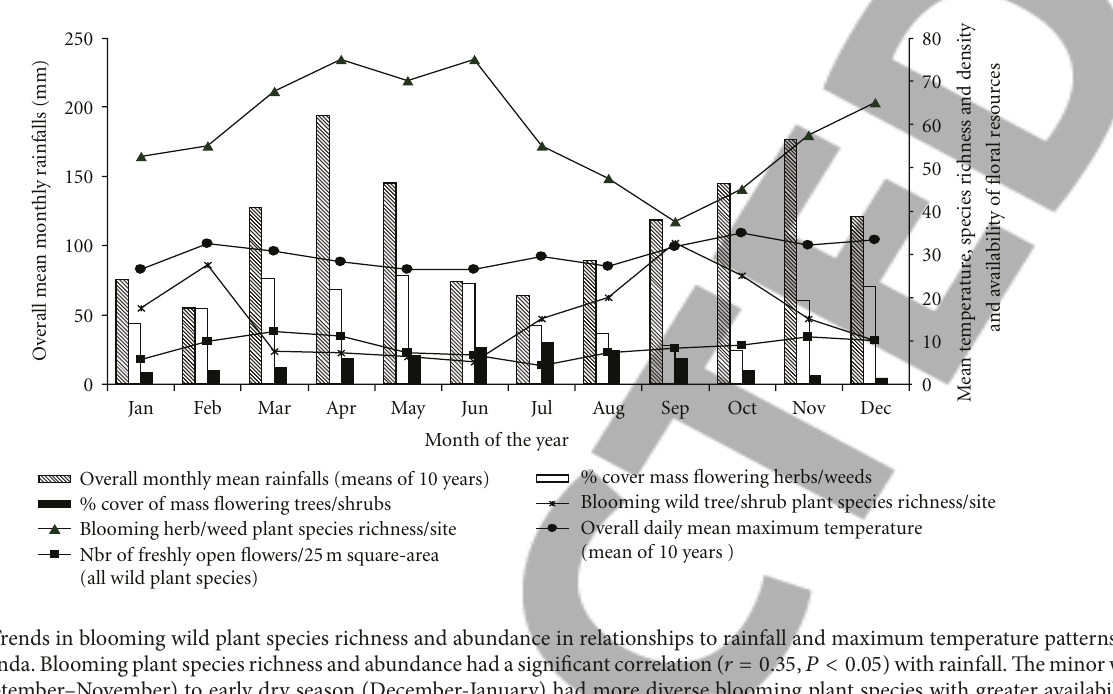
Figure 2: Trends in blooming wild plant species richness and abundance in relationships to rainfall and maximum temperature patterns in central Uganda. Blooming plant species richness and abundance had a significant correlation ( 𝑟 = 0.35 , 𝑃 < 0.05 ) with rainfall. The minor wet season (September–November) to early dry season (December-January) had more diverse blooming plant species with greater availability of herbs/weeds than trees and shrubs. However, both trees/shrubs and herbs/weeds blooming groups were least in June during the major wet season. Blooming tree/shrub richness showed a highly significant inverse correlation ( 𝑟 = 0.36 , 𝑃 < 0.05 ) with rainfall patterns. They declined a month ago after the start of the minor and major rainy seasons (September–March) and increased quickly two months later. This indicated that the two wild plant groups were not all in bloom at the same moment, and this is interesting for bees that need cover of floral resources around the year. Most (90%) blooming herbs and weeds were in full bloom towards the end of the major wet season and peaked in June-July when the maximum temperature was not high. The number of fresh flowers per 25 m square was not correlated to neither rainfall ( 𝑟 = 0.14 , 𝑃 > 0.05 ) nor to maximum temperature ( 𝑟 = 0.16, 𝑃 > 0.05